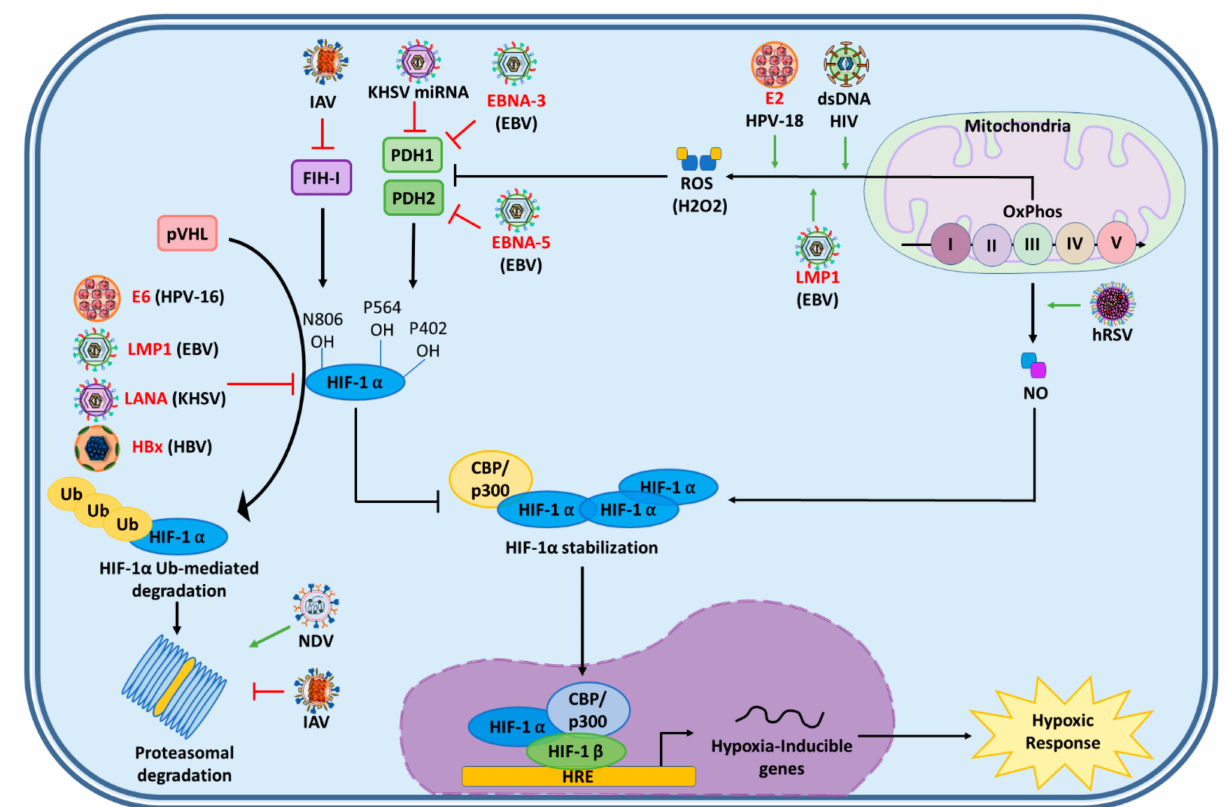
Figure 4. Viral modulation of HIF-1 α inhibitors. Several viruses have been reported to activate HIF-1 α and thus, promote the expression of hypoxia-inducible genes that are part of the hypoxic response. This is accomplished by the stabilization of HIF-1 α and avoidance of its proteasomal degradation. The E6 oncolytic protein from HPV-16, LMP-1 from EBV, LANA from KHSV, and HBx from HBV have all demonstrated the ability to inhibit HIF-1 α ubiquitination and target this protein to the proteasome. On the other hand, the influenza A virus has been reported to be able to directly inhibit the activity of FIH-1, while also inhibiting the proteasome. On the other hand, KHSV miRNAs inhibit PHD1 expression, while the EBV EBNA-3 and EBNA-5 proteins inhibit PHD1 and PHD2, respectively, promoting HIF-1 α stabilization. Lastly, hRSV, the HPV-18 E2 protein, the EBV LMP-1 protein, and dsDNA from HIV have been described to increase ROS production by the mitochondria (the former virus through NO, while the other through H2O2), which regulate HIF-1 stabilization by inhibiting PHDs function. Contrarily to the viruses mentioned above, NDV was found to promote proteasomal degradation of HIF-1 α . EBV: Epstein–Barr virus; KHSV: Kaposi’s sarcoma-associated herpesvirus; HPV: Human papillomavirus;